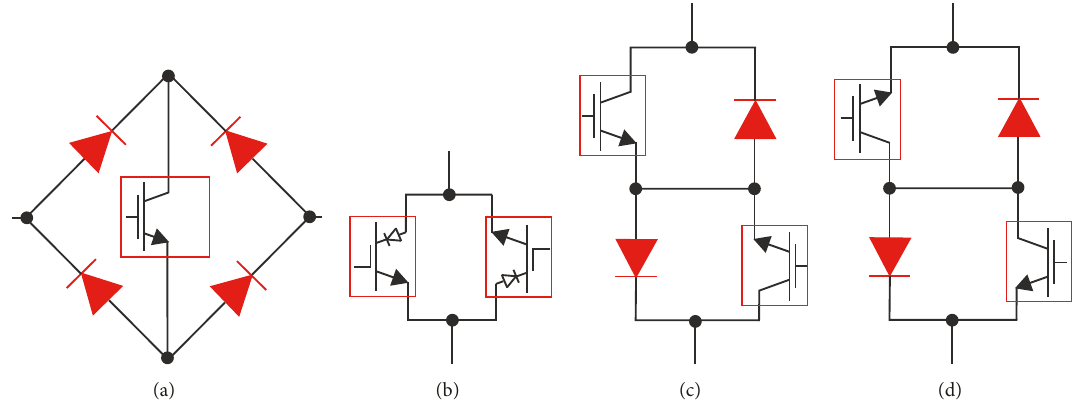
Figure 1: Topologies of the Bi-Sw (a) diode bridge with an IGBT arrangement, (b) anti-paralleled reverse blocking IGBTs (RB- IGBT) arrangement, (c) common emitter (CE) anti-paralleled IGBT arrangement, and (d) common collector (CC) anti-paralleled IGBT